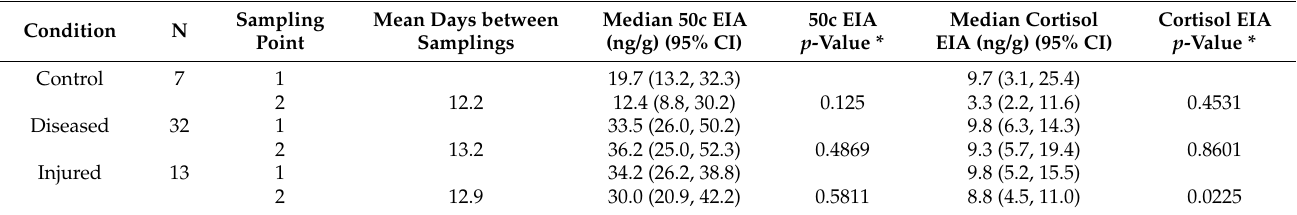
Table 2. Summary statistics for FCM (faecal cortisol metabolite) values (ng/g) measured by 50c and cortisol EIAs (enzyme immunoassays) for first and second scat collection (between the 10th and 15th day) for the control (N = 7), diseased (N = 32) and injured (N = 13).